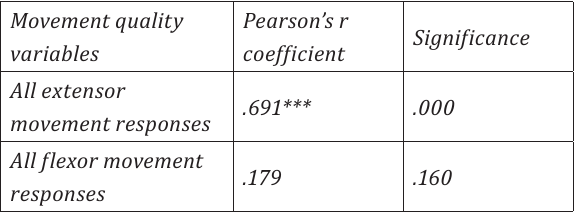
Table 8. Pearson’s r correlations in the group of parents of schizophrenic children (N = 63) between the “chiaroscuro” variable and movement quality variables